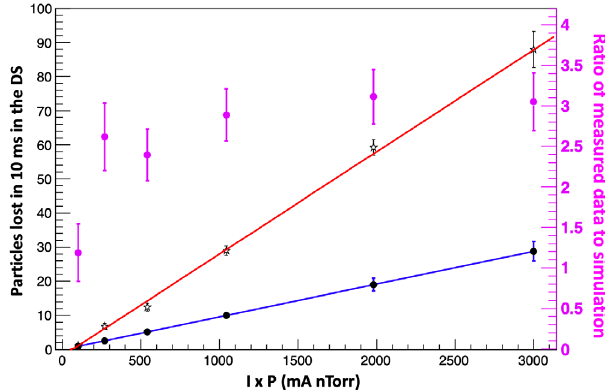
FIG. 18. Losses from beam-gas bremsstrahlung in the sCVD in the LER as a function of the product of the beam current and the vacuum pressure, from measurements in red and from simula- tions in blue and the ratio of measurement to simulation in magenta.